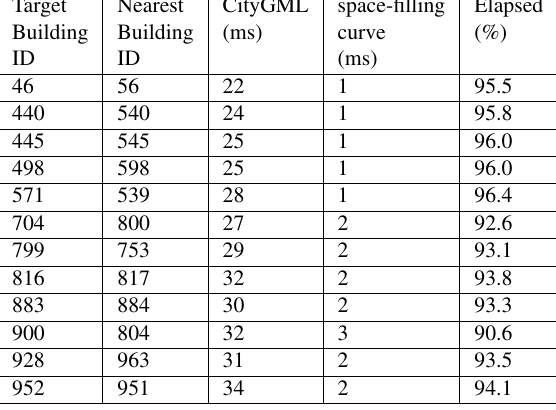
Table 2: Data retrieval time for nearest object from target